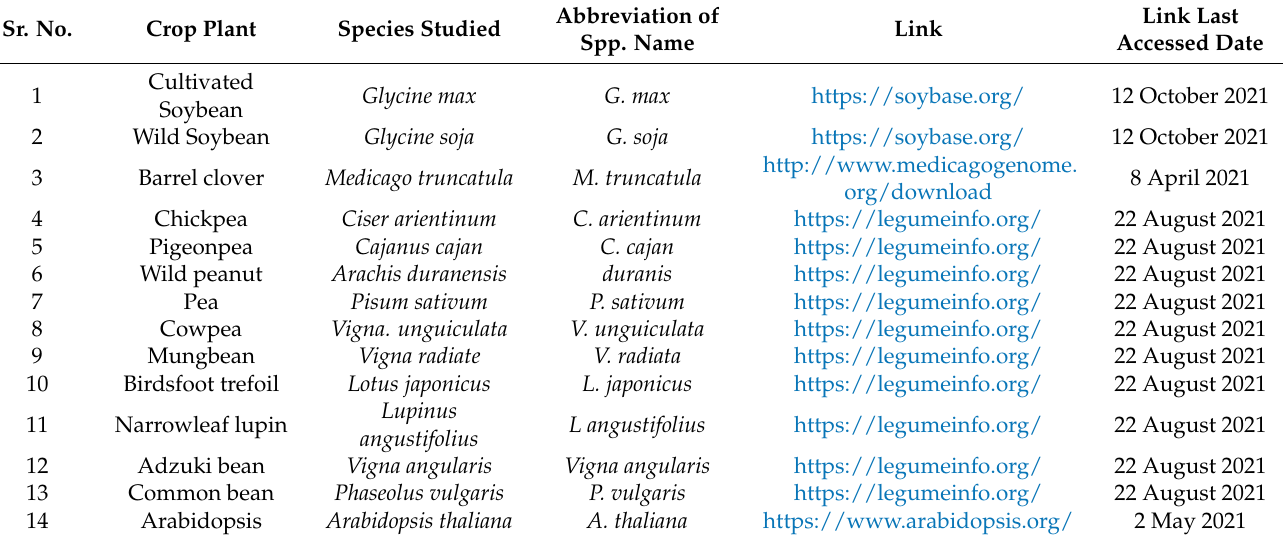
Table 1. List of studied species along with their genome database